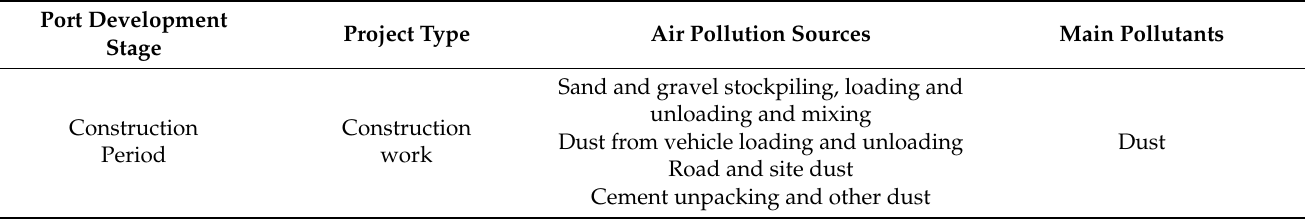
Table 3. Main air pollutants and pollution sources in the port (Adapted from